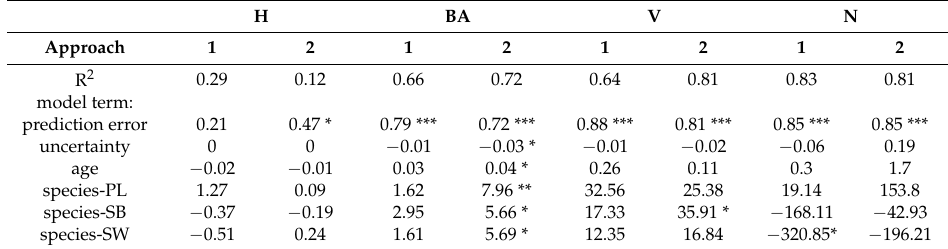
Table 5. Multiple regression analysis of the curve matching error.